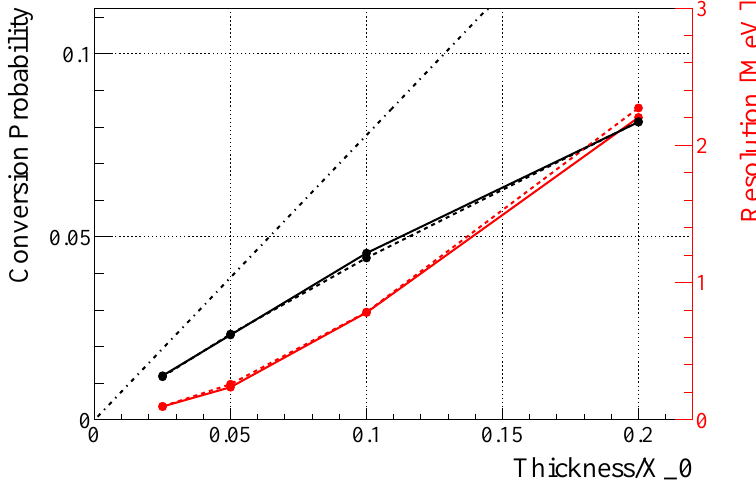
Figure 2. Conversion probability (black) and energy loss fluctuations in the converter (red) for Lead (full lines) and Tungsten (dashed line), as a function of the converter thickness (in units of radiation length, X 0 ). The conversion probability for high energy photons, 7/9 X 0 , is also shown (dash-dotted